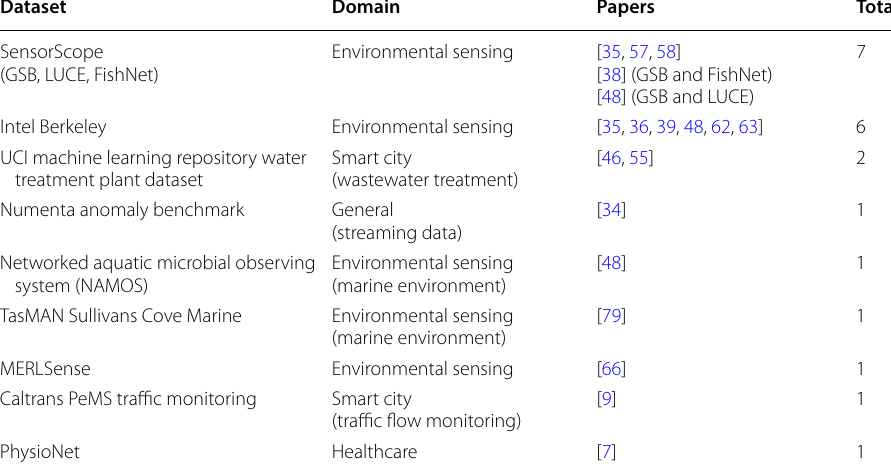
Table 7 Real-world publicly available datasets and its respective domains, along with the respective papers and total number of papers which used the datasets for performance